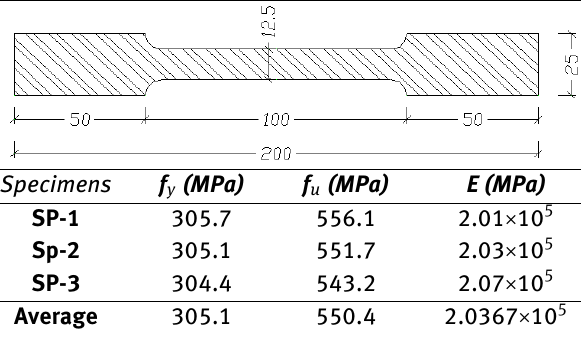
Figure 6: Tensile test of steel Table 2: Test Specimen and Steel Properties